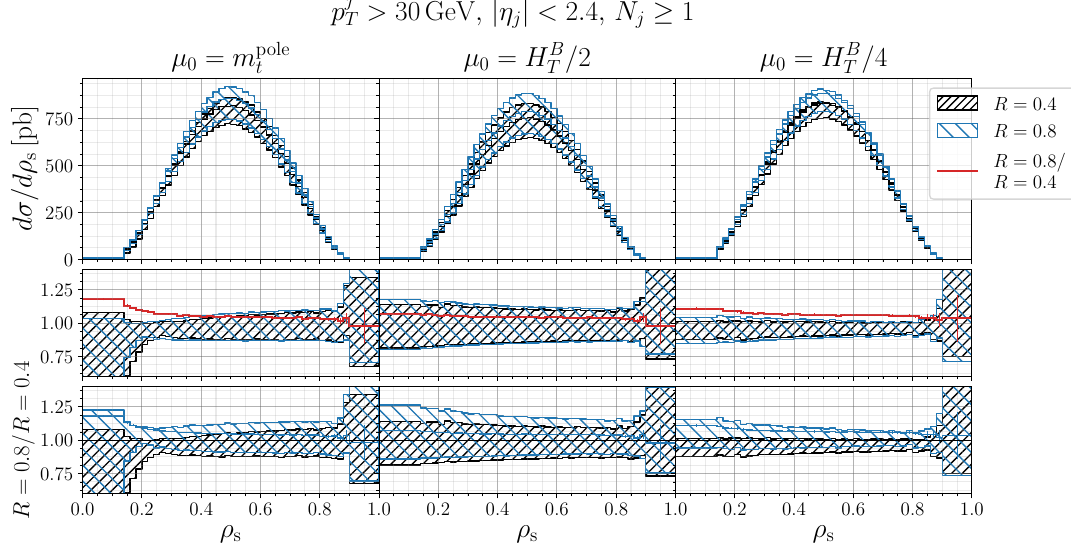
Figure 27 . NLO differential cross section as a function of ρ s calculated for the pp → t ¯ tj + X process √ at S = 13 TeV using the static central scale µ 0 = m t (left panel) and the dynamical central scales µ 0 = H B / 2 (central panel) and µ 0 = H B / 4 (right panel), varying the R -value in the anti- k T jet T T clustering algorithm from R = 0 . 4 (black) to R = 0 . 8 (blue). Thereby, besides central predictions, the uncertainty bands due to seven-point scale variation are shown. In the intermediate panel of each plot the relative size of each scale uncertainty band is shown. Thereby the ratio of the central scale prediction obtained with R = 0 . 8 and R = 0 . 4 is also plotted (red line). In the lower panel, all ratios are computed with respect to the central prediction with R = 0 . 4 .